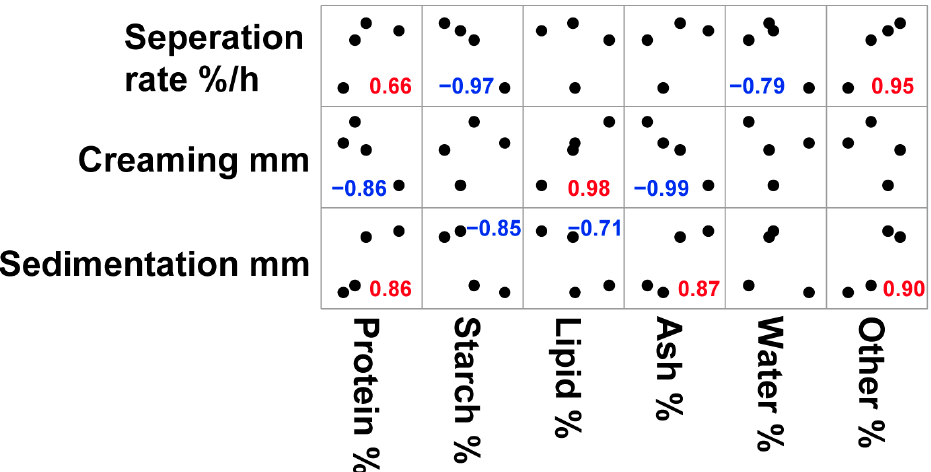
Figure 4. Correlation of nutritional composition of cultivars and physical stability of oat milk. The red number represents the positive correlation of the two parameters. The blue number represents the negative correlation of the two parameters.